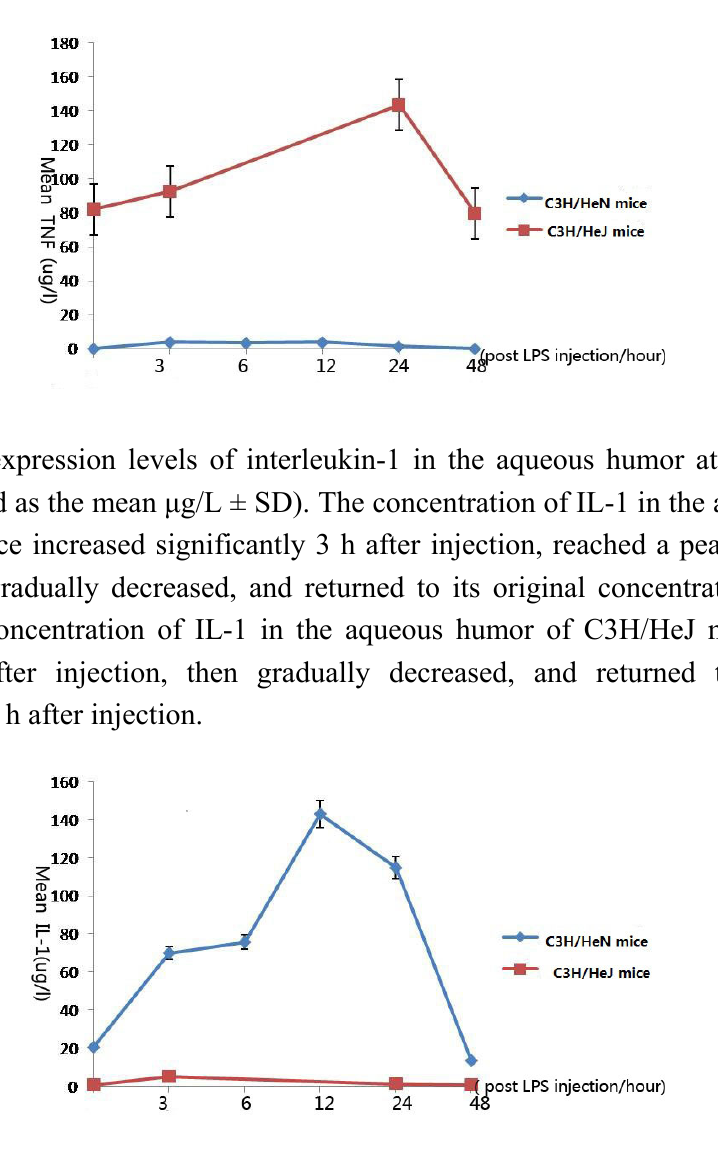
Figure 1. The expression levels of tumor necrosis factor- α in the aqueous humor at different time points (expressed as the mean μ g/L ± SD). The concentration of TNF- α in the aqueous humor of C3H/HeN mice reached a peak 3 h after injection, then gradually decreased 12 h after injection, the concentration reached the second peak. After 48 h, TNF- α concentration in the aqueous humor returned to their original levels. The concentration of TNF- α in the aqueous humor of C3H/HeJ mice reached a peak 24 h after injection, then gradually decreased.